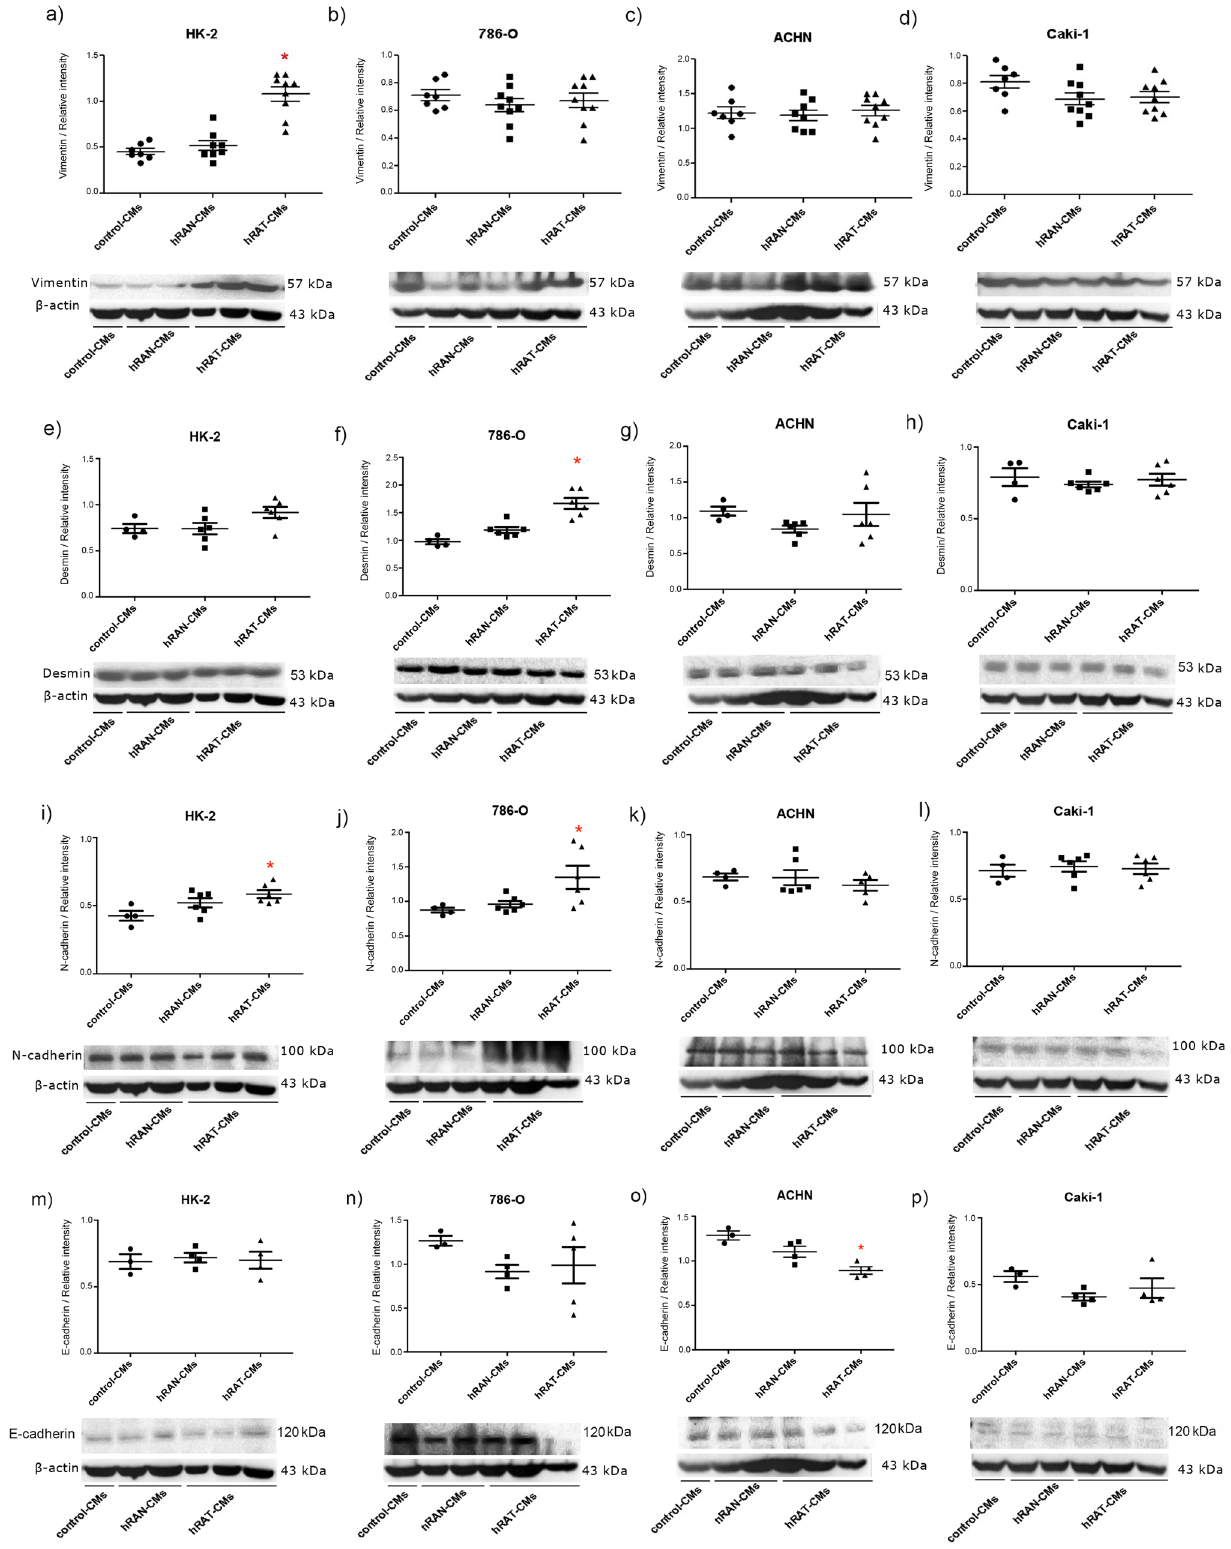
Figure 5. Effect of CMs from hRAN and hRAT on: vimentin ( a – d ); desmin ( e – h ), N-cadherin ( i – l ) and E-cadherin ( m – p ) expression was evaluated in HK-2, 786-O, ACHN and Caki-1 cell lines. HK-2, 786-O, ACHN and Caki-1 cells were grown on 6 well plates, incubated for 24 h with the different CMs and then lysed. Expression of the different proteins was measured by Western blot. β-actin was used as internal control. Images were analyzed by densitometry. Horizontal bars represent the geometric mean of each data set. Vertical bars indicate SEM. * p < 0.05 cells incubated with hRAT-CMs versus hRAN- and